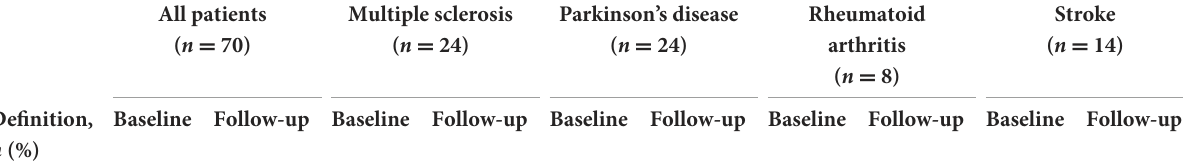
TABLE 2 The modified Ranking Scale-9 Questionnaire measured at baseline and at 1 year follow-up in patients with four chronic diseases. All